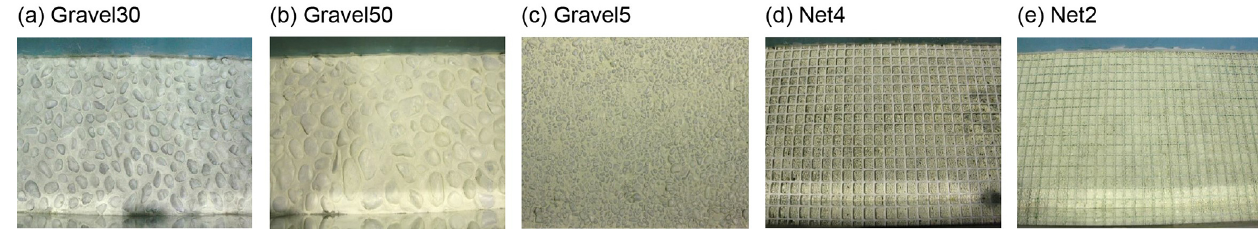
Figure 1. Initial channel bed for each run. (a) Gravel30 is embedded with 30mm gravel. (b) Gravel50 is embedded with 50mm gravel. (c) Gravel5 is embedded with 5mm gravel. (d) Net4 is installed with a net of height 4mm. (e) Net2 is installed with a net of height